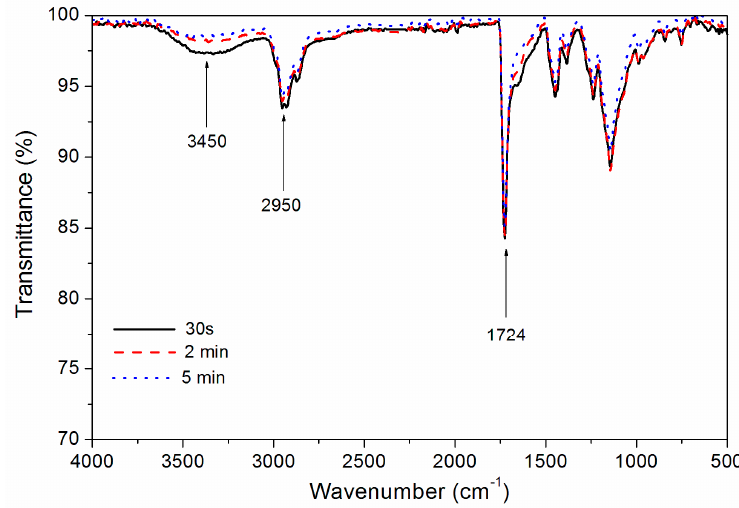
ff ect of drying time on infrared spectrum of the coating. Figure 2. Effect of drying time on infrared spectrum of the coating. Figure 2. E Figure 2. Effect of drying time on infrared spectrum of the